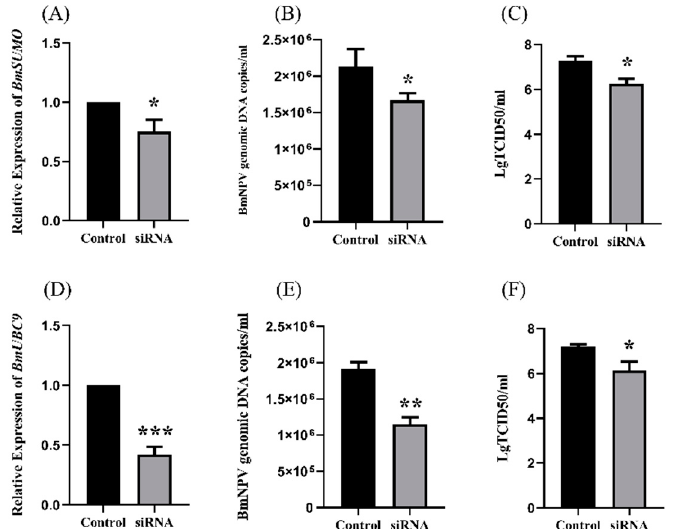
Figure 2. Knockdown of BmSUMO and BmUBC9 inhibited BmNPV replication. ( A ) Expression level analysis of BmSUMO at 24 h after transfection with siRNA. ( B , C ) DNA copies and budded virus titer of BmNPV in the control and BmSUMO -knockdown cells at 48 hpi. ( D – F ) The same as BmSUMO but with BmUBC9 . The error bars indicate the SDs of averages from three independent experiments with three technical replicates. Statistical analysis was applied with SPSS software. One-way ANOVA with Tukey’s post-test was used. Significant differences are indicated by asterisks (* p < 0.05; ** p < 0.01; *** p <